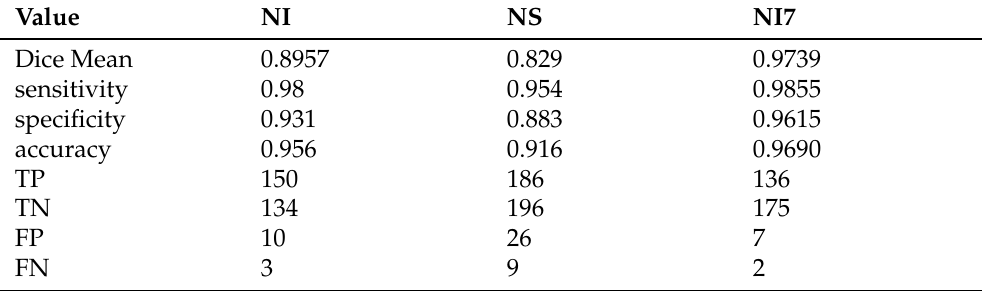
Table 7. Material Segmentation results.